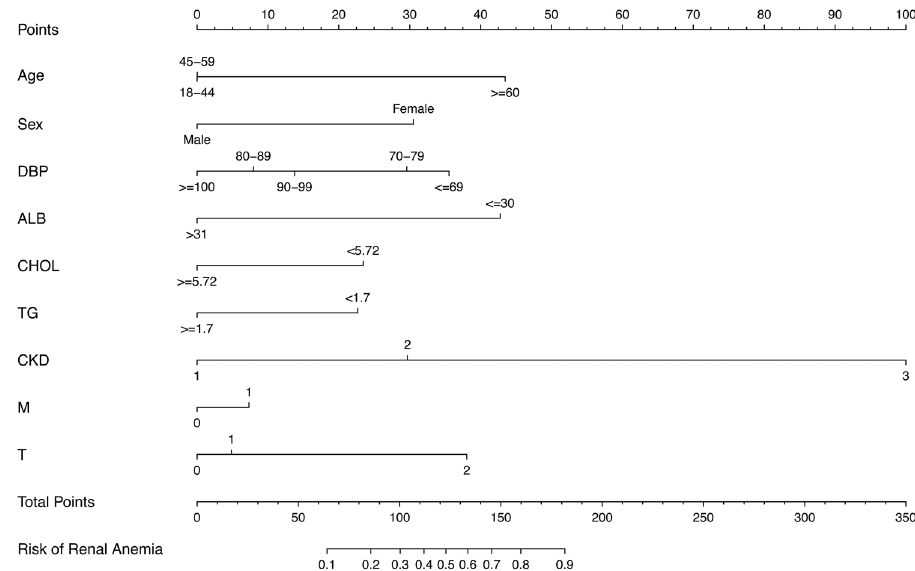
Figure 2: Developed IgA nephropathy patients complicated with renal anaemia nomogram. The renal anaemia nomogram was developed in the cohort, with nine variables, age, sex, DBP, ALB, CHOL, TG, CKD stage, M, and T. Abbreviations: CKD 1, stages 1 – 2 CKD; CKD 2, stage 3 CKD; CKD 3, stages 4 – 5 CKD; DBP, diastolic blood pressure; ALB, serum albumin; CHOL, cholesterol; TG, triglyceride; CKD stage, chronic kidney disease stage; M, mesangial hypercellularity; T, tubular atrophy/interstitial fi brosis.